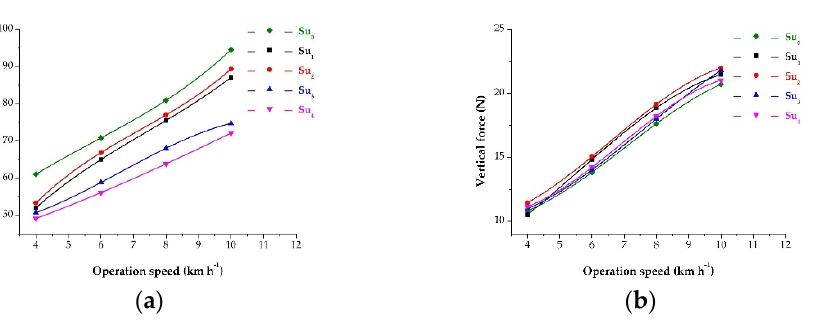
Figure 14. Opening furrow force predicted by discrete element test. ( a ) Horizontal force; ( b ) Vertical force.